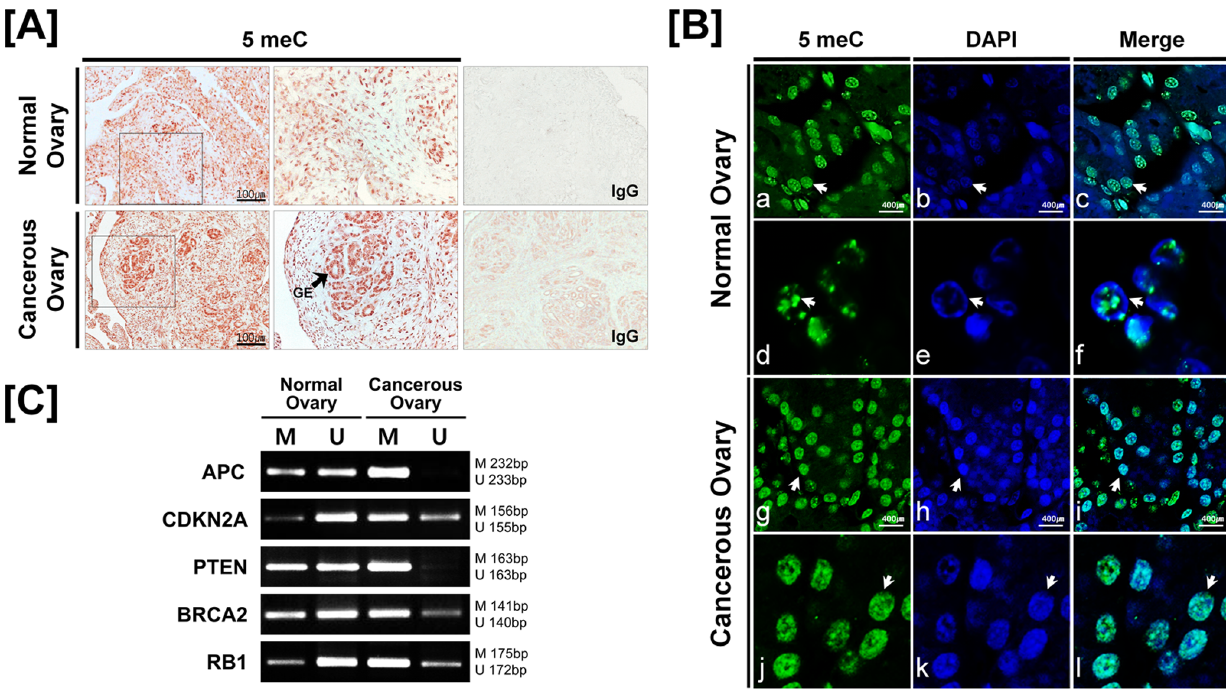
Figure 2. Methylation patterns of DNMTs and tumor suppressor genes in normal and cancerous ovaries from laying hens. [A and B] Localization of 5-methylcytosine protein in normal and cancerous ovaries of hens. Sections were not counterstained. Arrows in panel B indicate nuclei